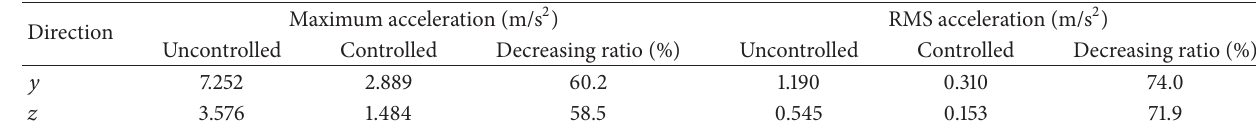
Table 7: Results for Northridge earthquake.